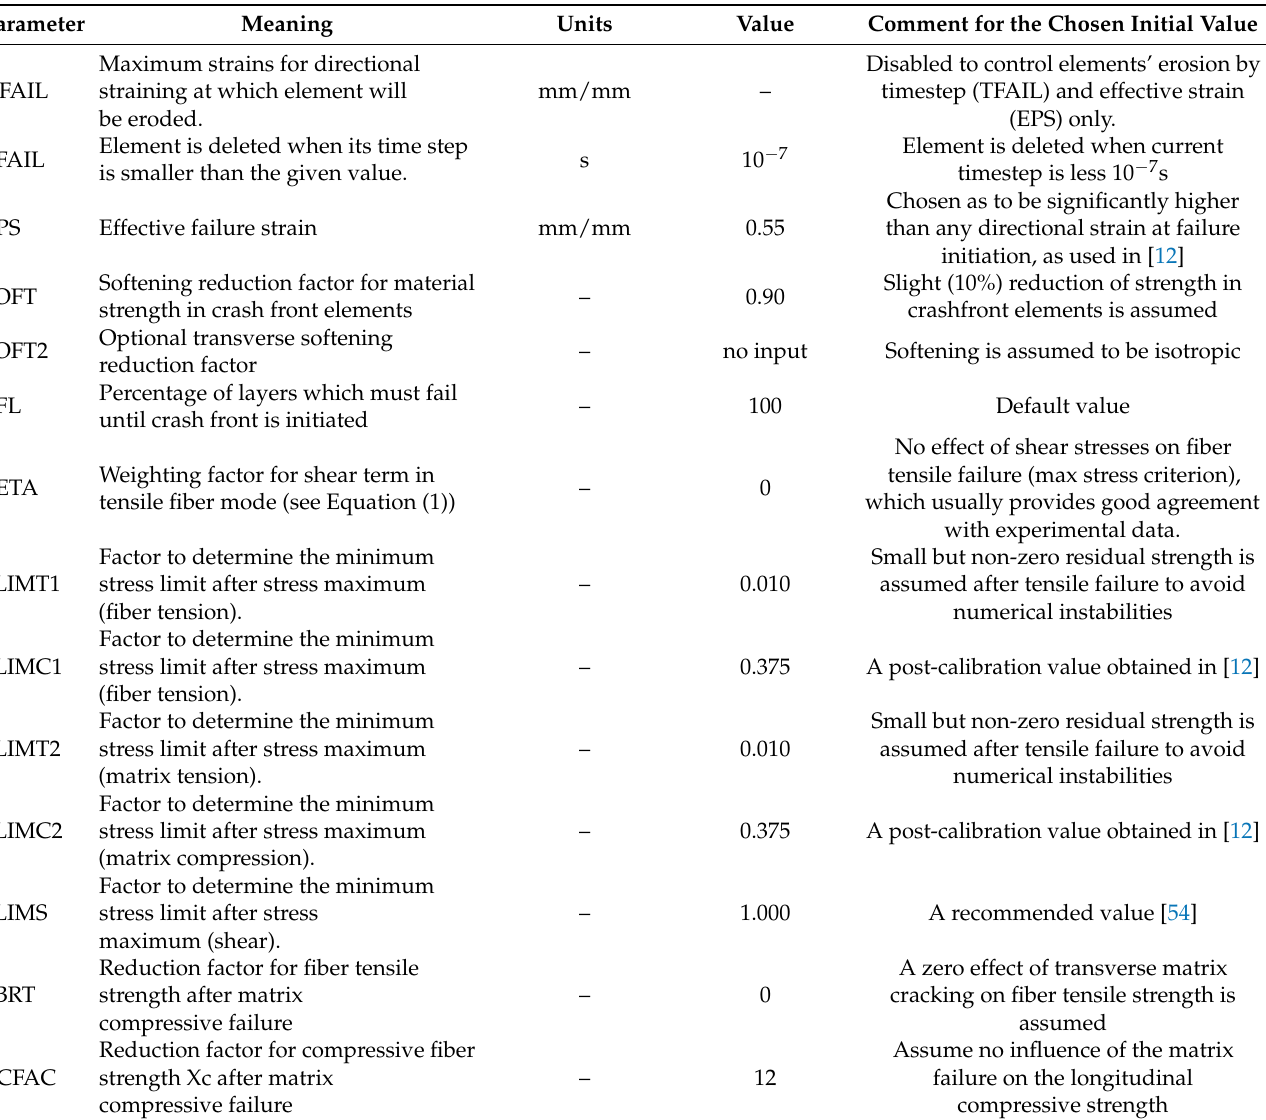
Table 3. The non-physical parameters for MAT